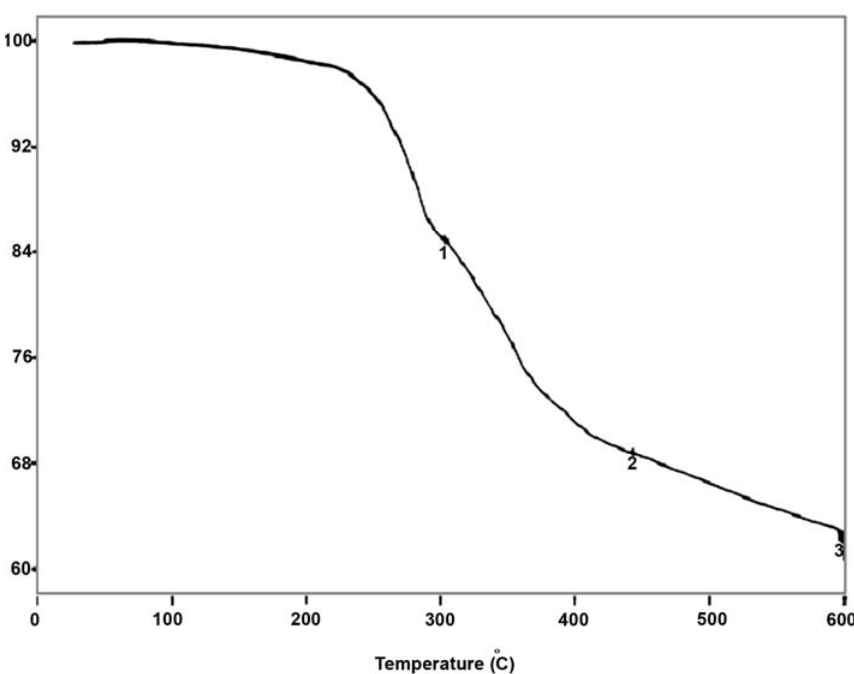
Figure 5. Thermogravimetric data for compound